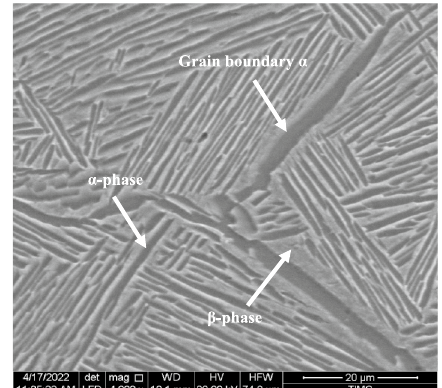
Fig. 1 TC21 Ti-alloy